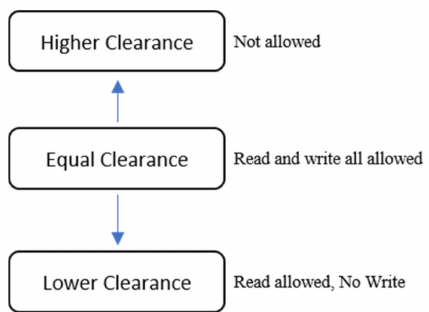
Figure 4. Clearance security rule.